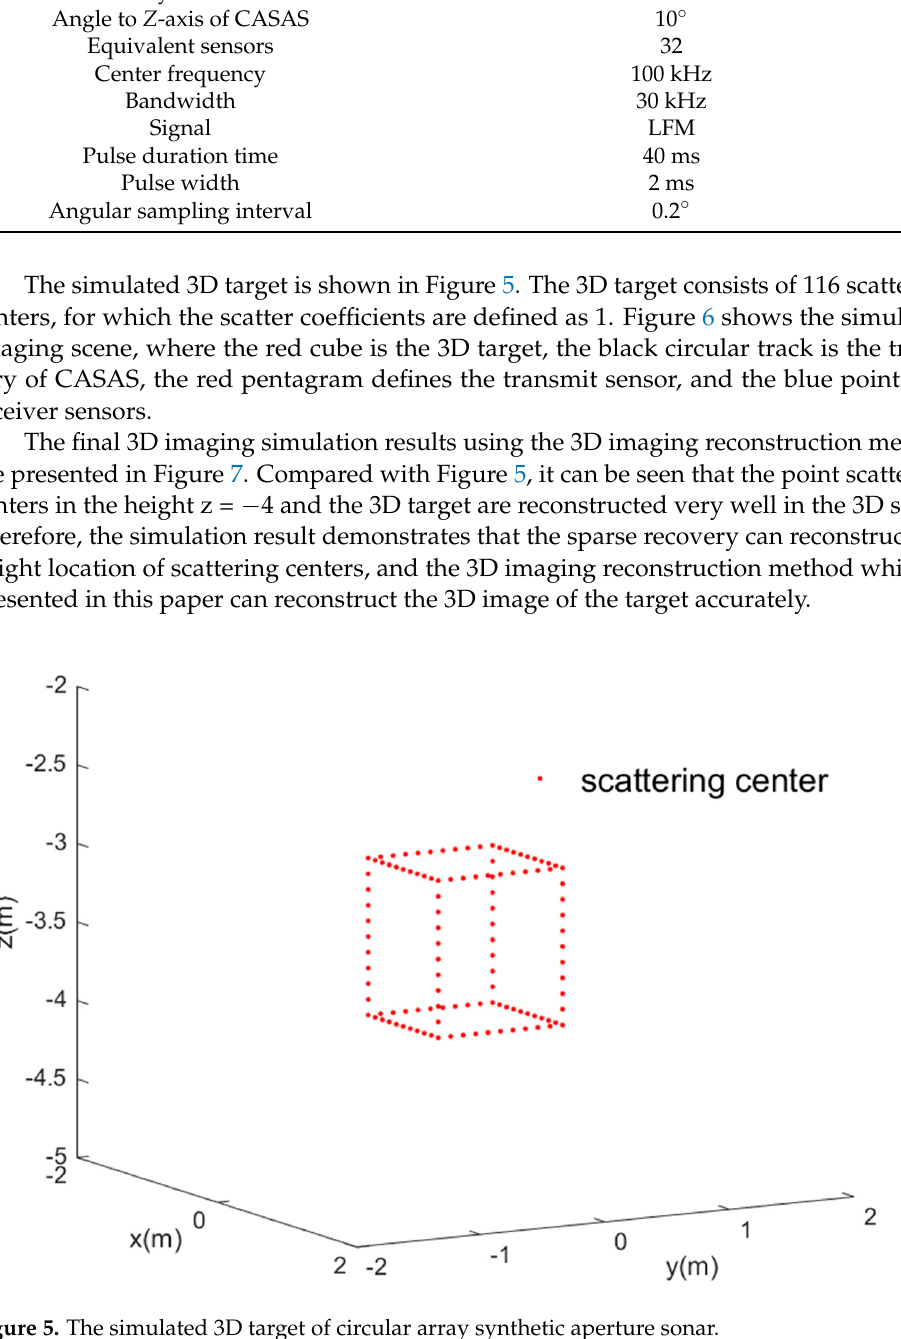
Figure 5. The simulated 3D target of circular array synthetic aperture sonar.